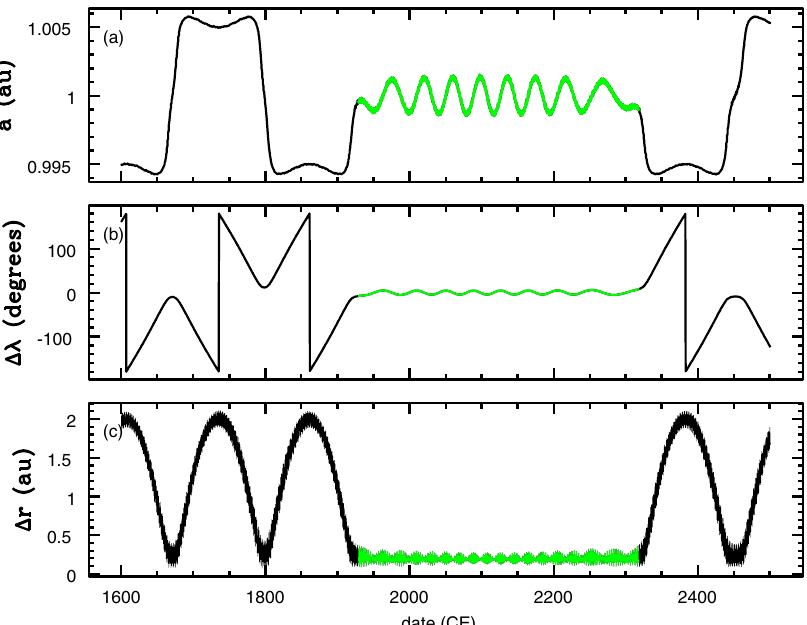
Fig. 4 Kamo ʻ oalewa ’ s Current Orbital State. a Orbital variation of the semi-major axis of Kamo ʻ oalewa over ± 500 years; b time variation of the mean longitude relative to Earth ’ s; ( c ) time variation of Kamo ʻ oalewa ’ s geocentric distance. The green track indicates the quasi-satellite state when the asteroid ’ s semi-major axis as well as mean longitude remains very close to Earth ’ s; the black track indicates the horseshoe state when the asteroid ’ s semi-major axis alternates between superior and inferior to Earth ’ s as its mean longitude approaches and recedes from Earth ’ s. (Based on the DE430/431 planetary ephemeris 60 , data provided by the Jet Propulsion Laboratory ’ s HORIZONS on-line solar system data and ephemeris computation service; retrieved July 3,